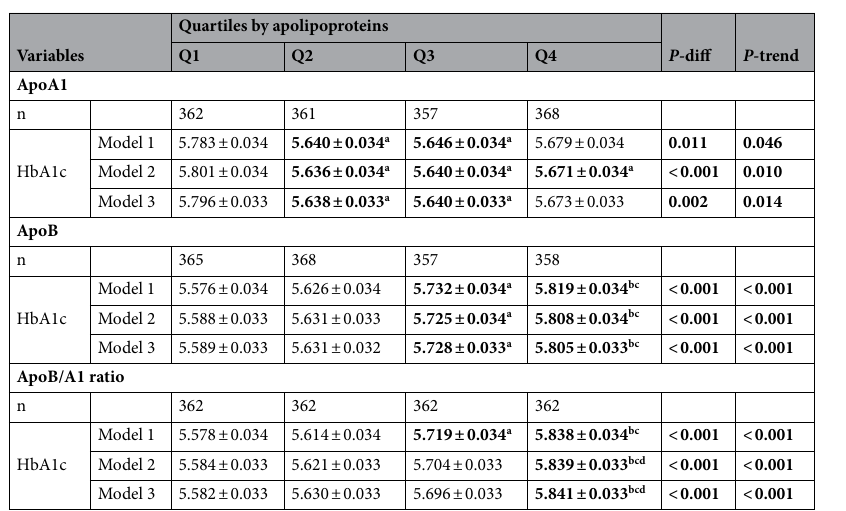
Table 3. Mean HbA1c level according to quartiles of apolipoprotein in all participants (mean ± SE). Apo apolipoprotein, HbA1c glycosylated hemoglobin, Q quartile. P -Diff: Multiple comparison among quartiles. Model 1 was univariate analysis. Model 2 was adjusted for sex, age. Model 3 further adjusted for BMI, education, marriage, exercise, cigarette smoking, alcohol consumption, hypoglycaemic agent, and lipid- lowering drugs use. a P < 0.05 compared with Q1. b P < 0.001 compared with Q1. c P < 0.001 compared with Q2. d P < 0.05 compared with Q3. Significant values are in